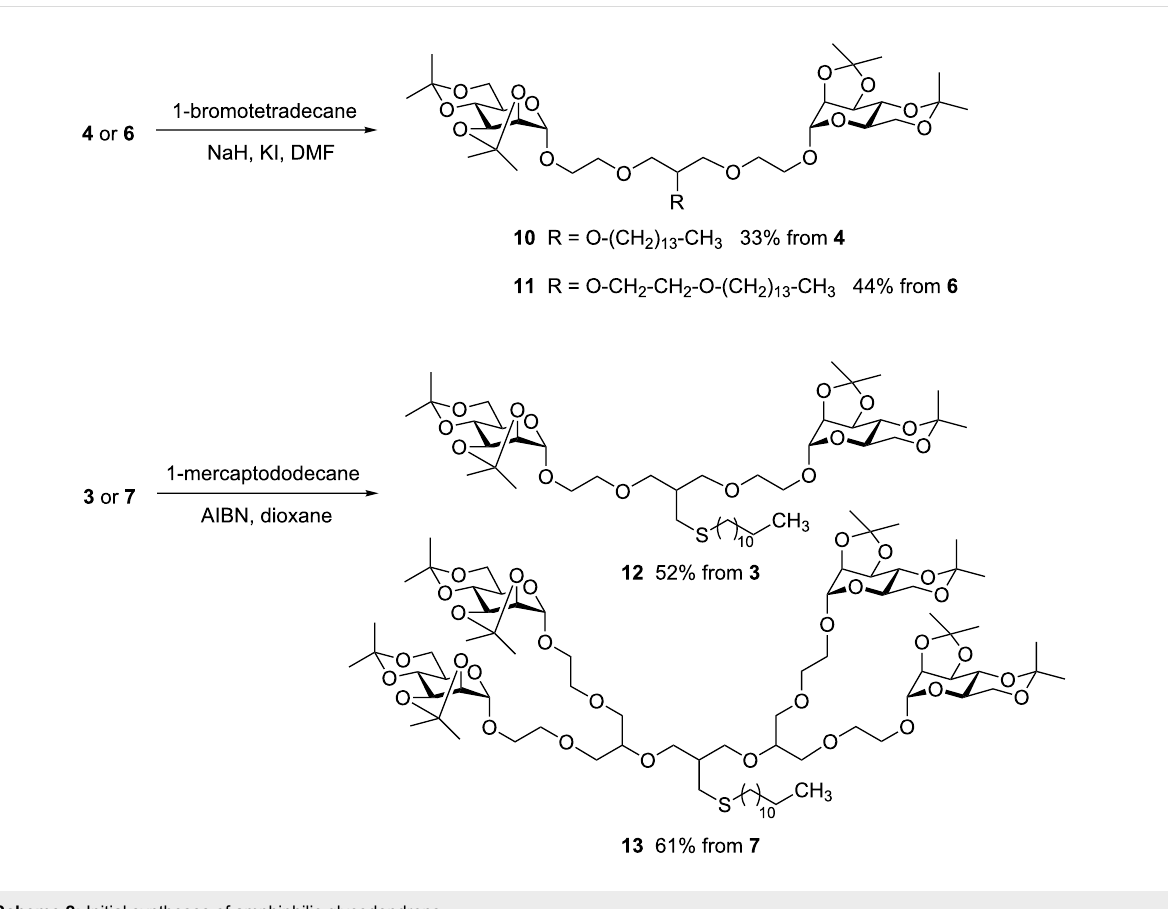
Scheme 2: Initial syntheses of amphiphilic